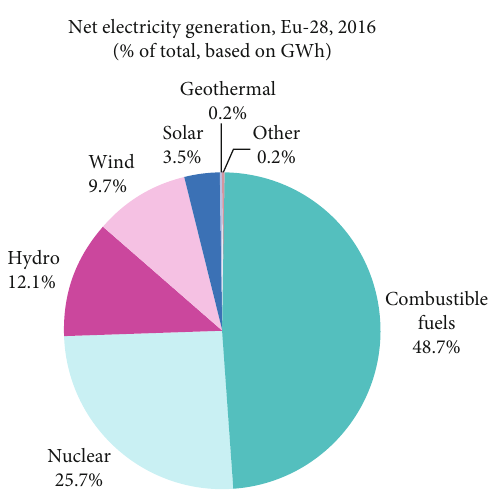
Figure 12: Electricity generation in Europe from 1990 to 2017 [3].